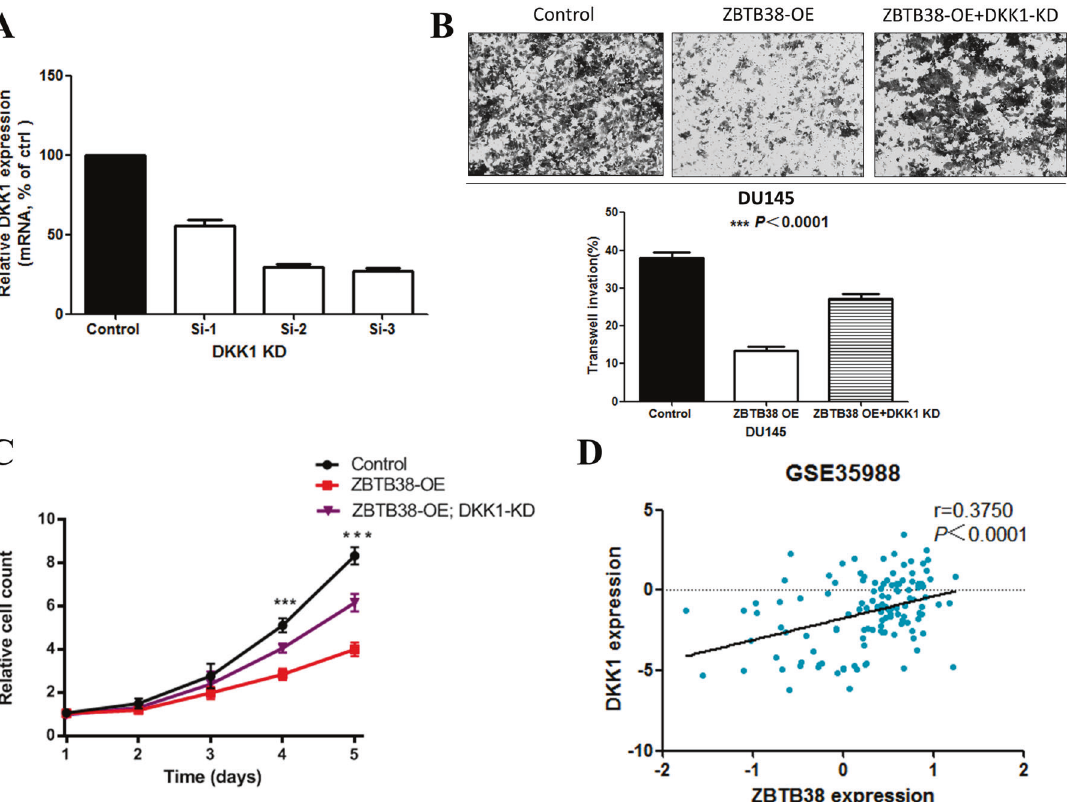
Fig. 4 ZBTB38 suppresses prostate cancer cell proliferation and migration through promoting DKK1 expression. A RT-qPCR showed the mRNA levels of DKK1 gene in the DU145 cells with a control vector or DKK1 knockdown SiRNA. B DKK1 knockdown rescued ZBTB38 -mediated reduced cell migration. One-way ANOVA analysis was used. C DKK1 knockdown rescued ZBTB38 -mediated reduced cell proliferation (** P < 0.01, *** P < 0.001). D Expression correlation analyses of ZBTB38 and DKK1 mRNA levels in prostate cancer samples from